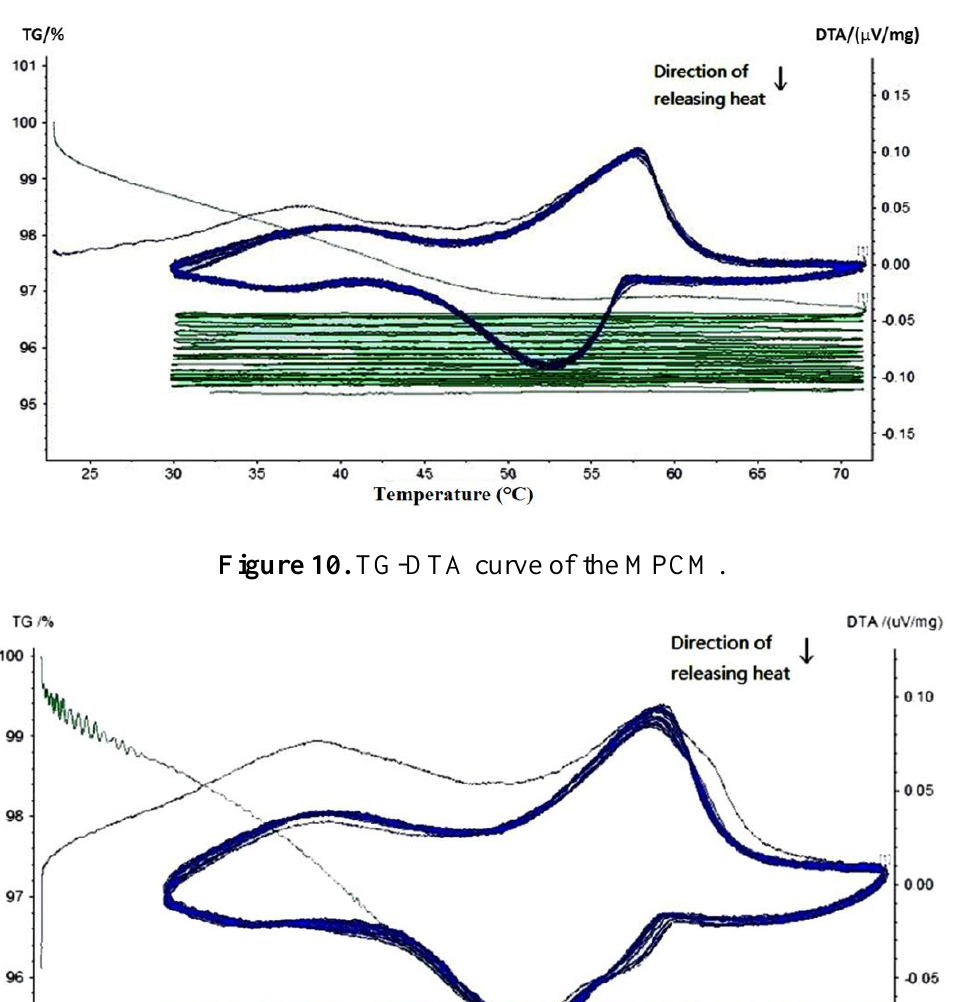
Figure 9. TG-DTA curve of the pure paraffin.